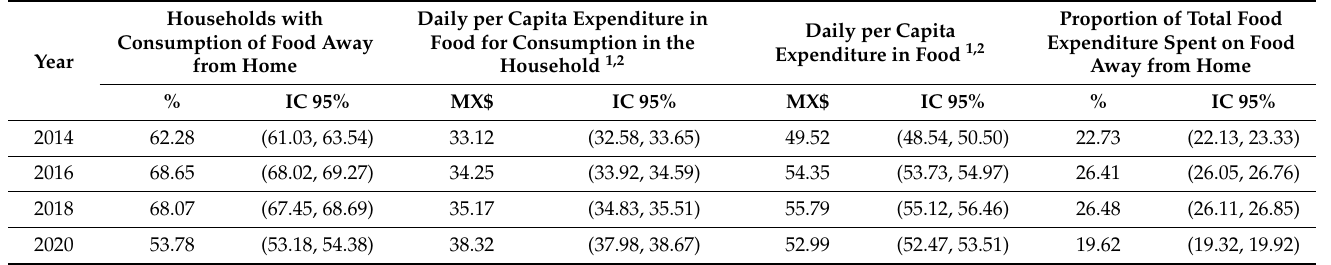
Table 2. Evolution of the proportion of households and average daily expenditure on food, food for consumption in the household, and food consumed away from home, Mexico